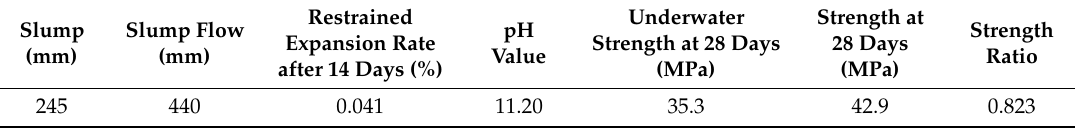
Table 21. Index for optimal mix ratio of